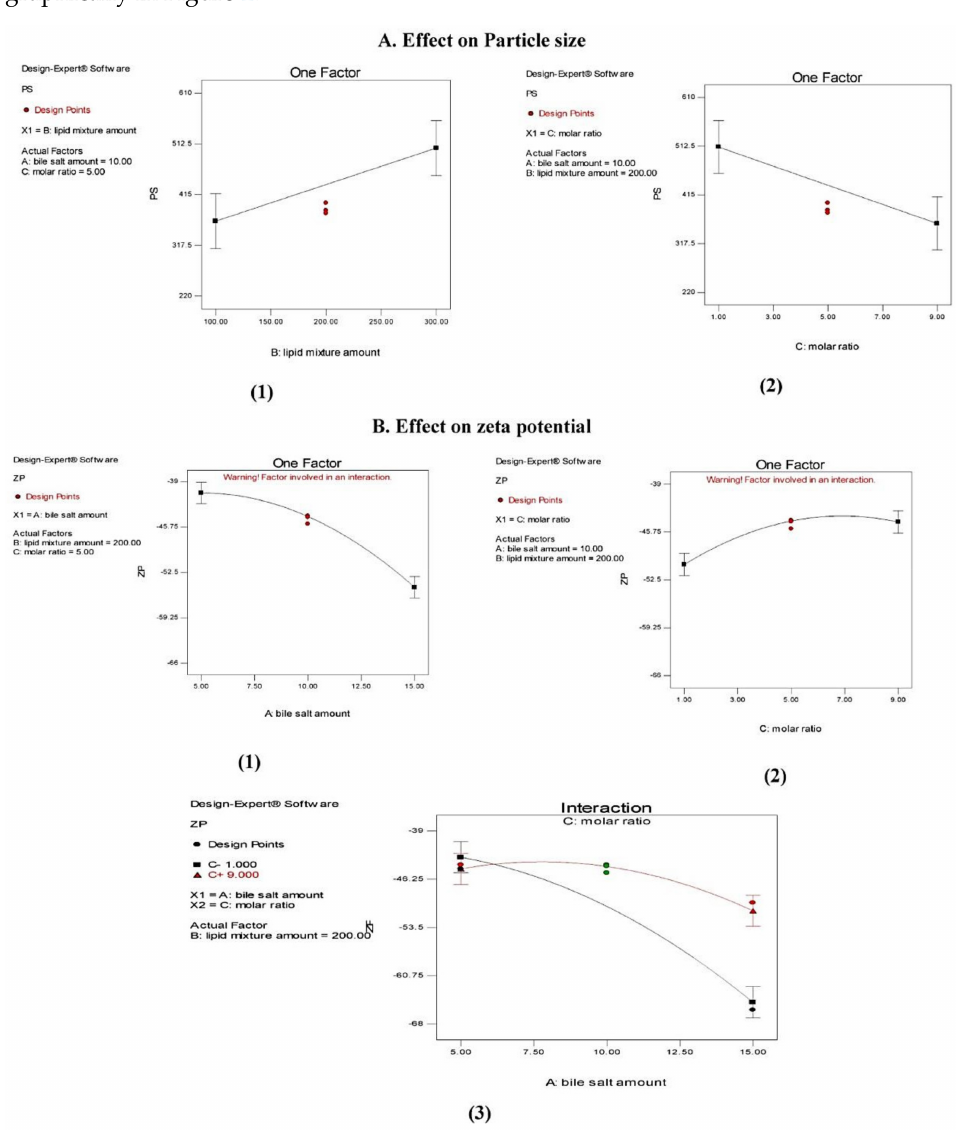
Figure 2. ( A ) Line plots of the effects of cholesterol/Span ® 40 mixture amount and (1) cholesterol: Span ® 40 molar ratio (2) on particle size. ( B ) Line plots for the effects of sodium deoxycholate amount (1), cholesterol: Span ® 40 molar ratio and (2) the interaction between them (3) on zeta potential of the prepared zolmitriptan-loaded